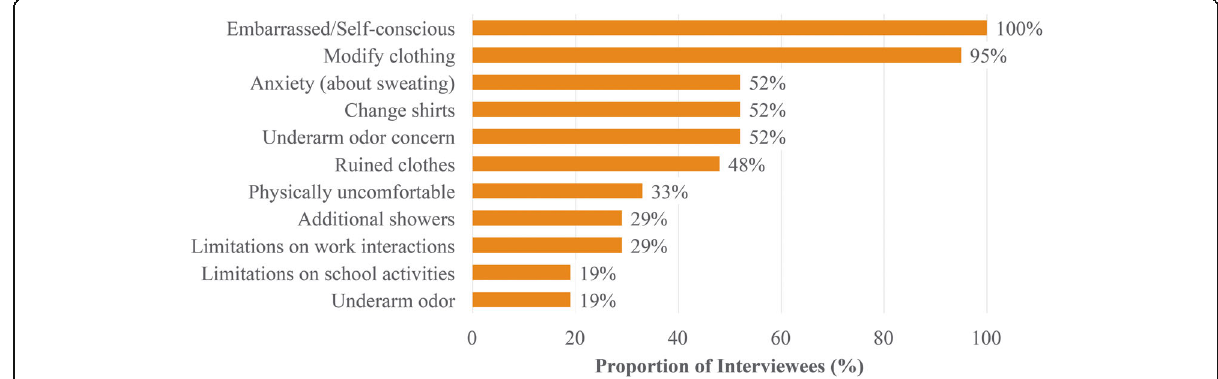
Fig. 2 Areas of bother and impact associated with axillary hyperhidrosis (Adult Patient Interviews; N =